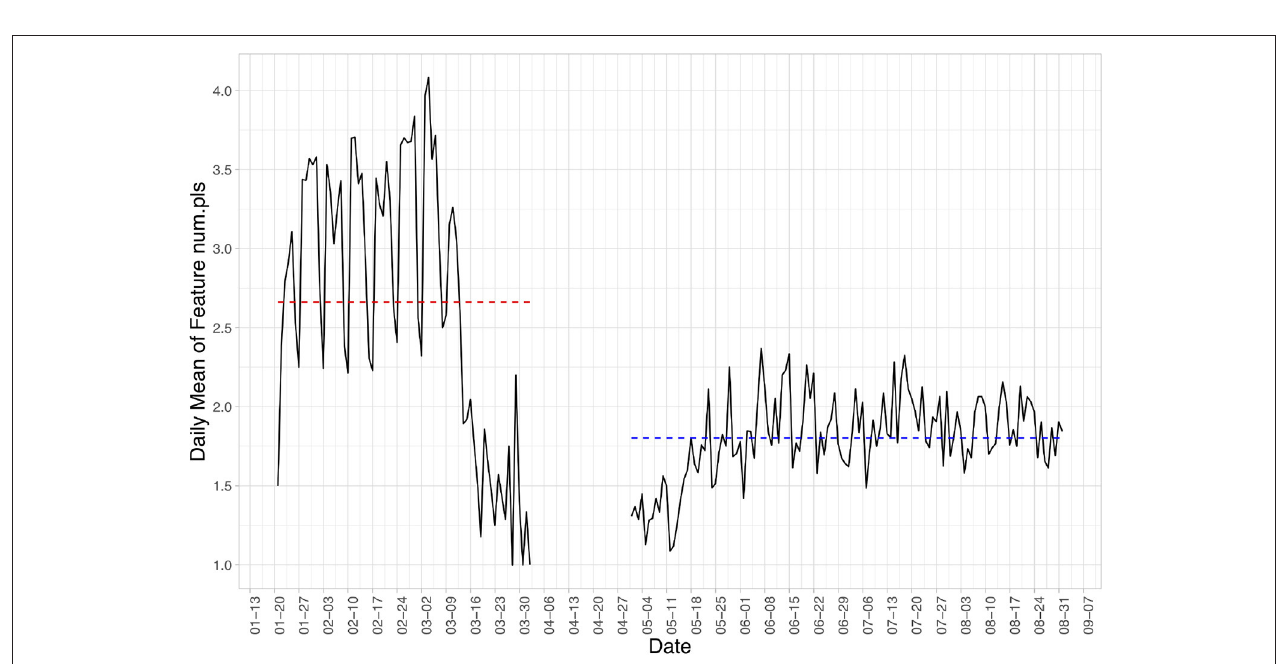
FIGURE 3 | Daily mean value of Principal Component No.4 (PC4) over the two study periods. The red and blue dashed lines indicate the average value from the pre- and post-outbreak group, respectively.